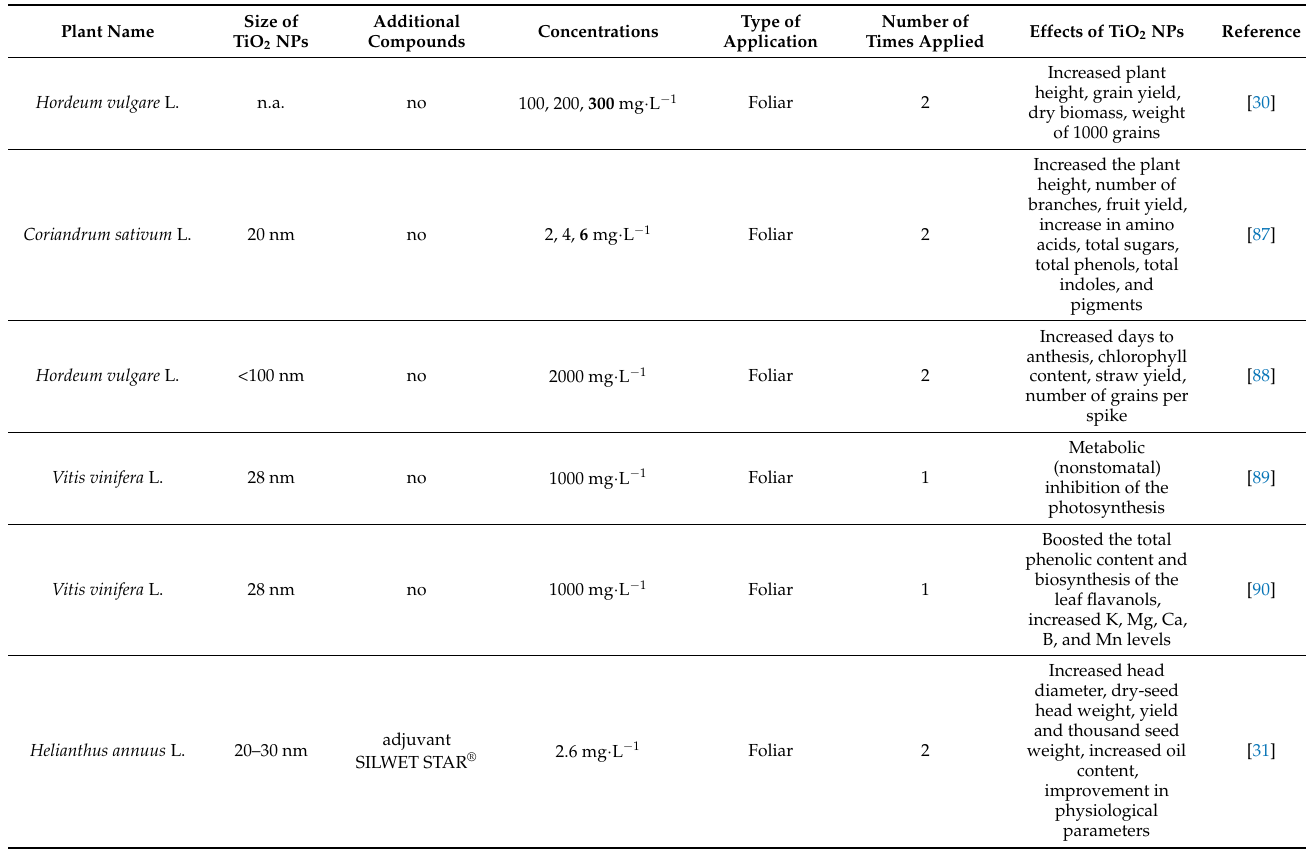
Table 2. Effects of TiO 2 NPs in higher plants grown under the field